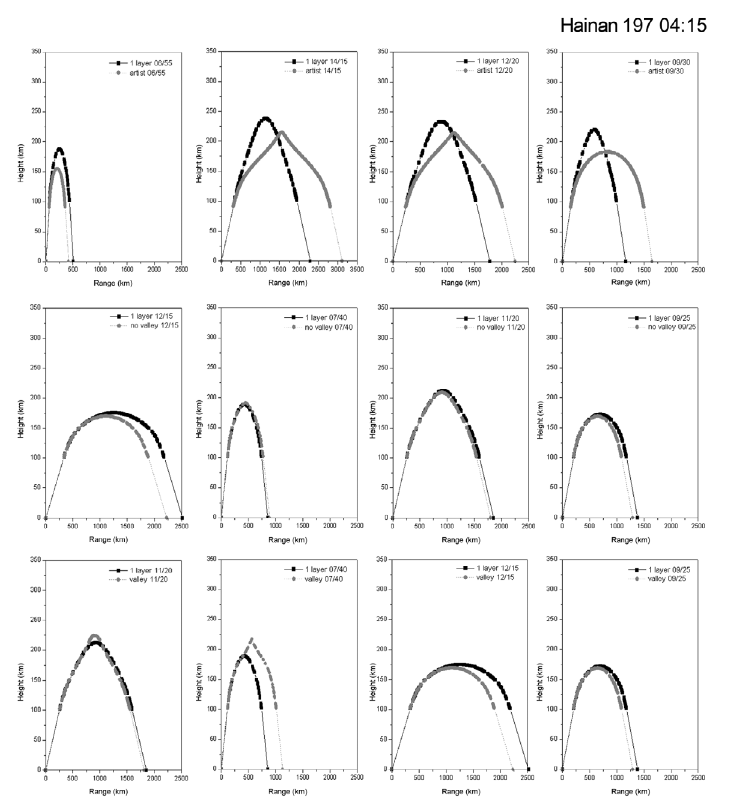
Fig. 2. Worst cases for the range values differences during the ionospheric conditions described by fig. 1.